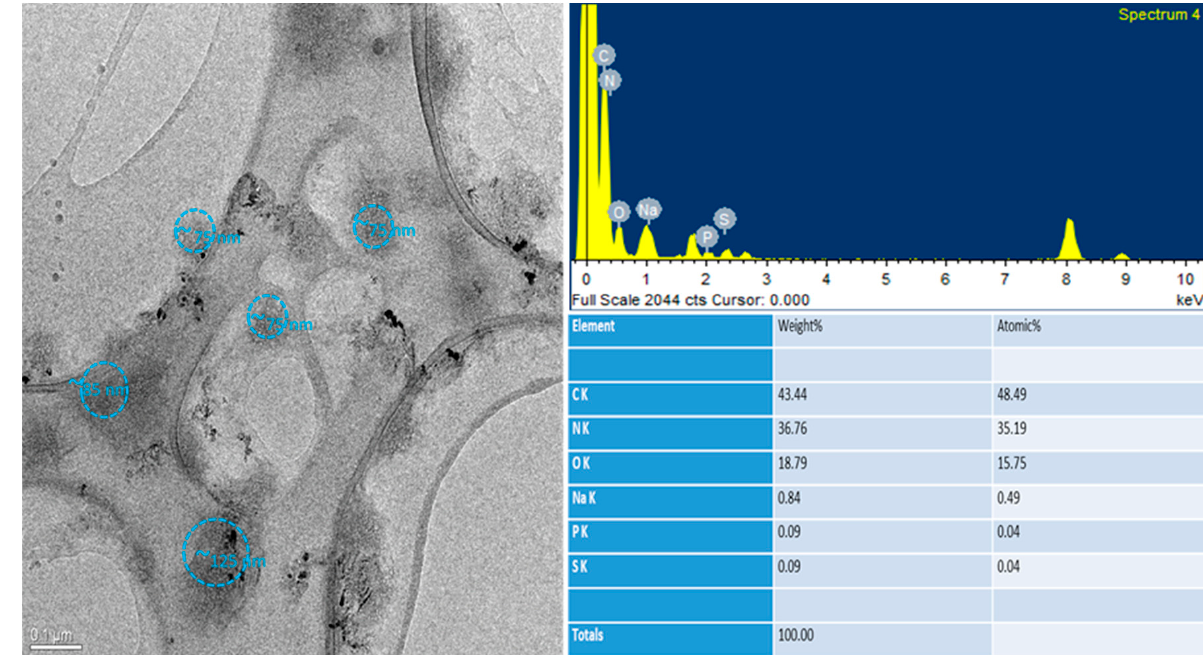
Figure 6. Morphological and elemental analysis of NP-CTAB by TEM .